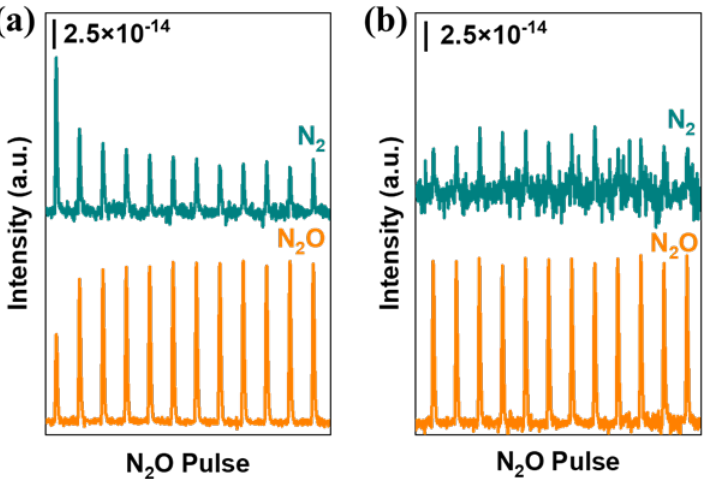
Figure 8. Monitoring of N 2 O consumption and N 2 formation during N 2 O pulses by mass spectrom- eter at 50 °C over ( a ) FSP-CuCe and ( b ) CP-CuCe catalysts. The samples were firstly reduced by CO at 200 °C, then 5%N 2 O/He was pulsed into the reactor 12